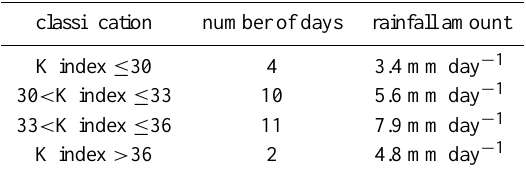
Table 2. Daily rainfall amount at the radar site classified by K index during November 2001.